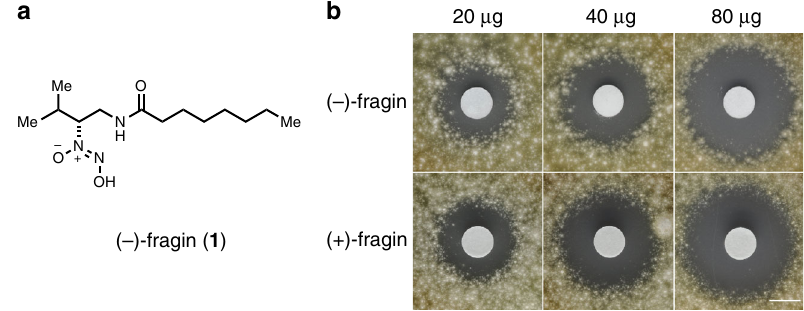
Fig. 4 Activities of ( − )-fragin ( 1 ) and ( + )-fragin ( 11 ). a Structure of ( − )-fragin ( 1 ). b Disc diffusion assays of synthetic ( − )- and ( + )-fragin to determine the antifungal activity. Representative pictures of an antifungal spray assay against the fungus F. solani are shown. Scale bar indicates 10 mm